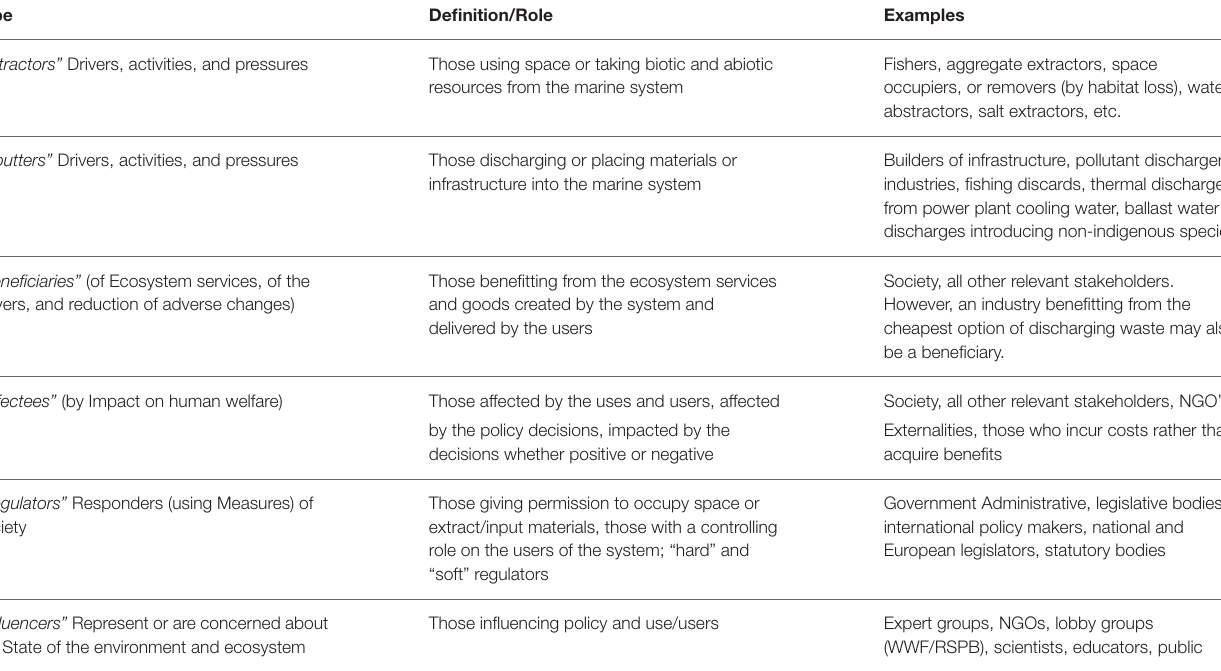
TABLE 2 | Typology and roles of stakeholders with some illustrative